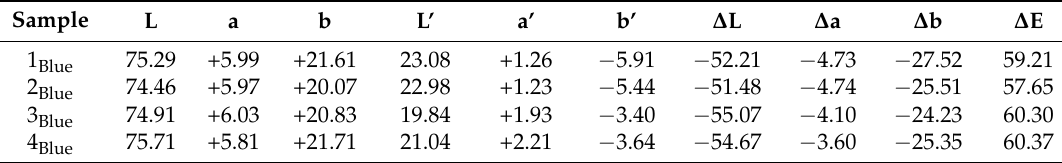
Table 4. L 4 (2 3 ) orthogonal test of chromatic aberration with reactive